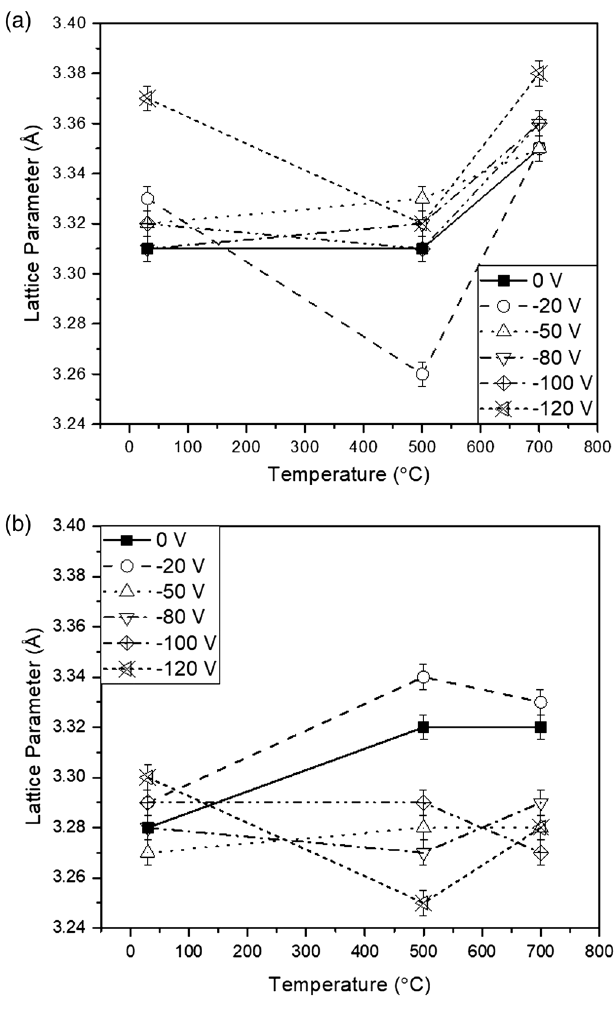
FIG. 12. The calculated lattice parameters of niobium thin films deposited at either room temperature, 500 °C or 700 °C with bias voltages of 0, − 20 , − 50 , − 80 , − 100 or − 120 V with (a) the copper substrate removed by etching or (b) with the copper substrate still in place.